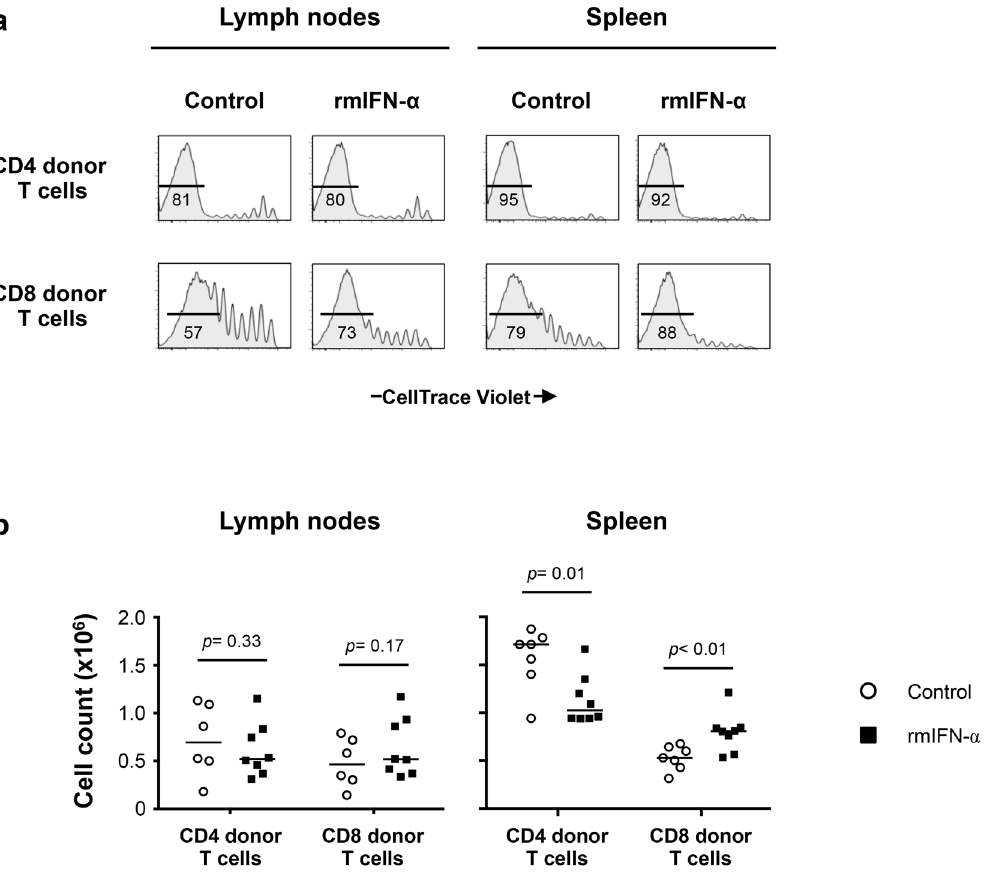
Figure 7. Continuous exposure to Type-I IFN under lymphopenic conditions leads to CD4 T cell depletion and CD8 T cell expansion. Lymphopenic RAG 2 / 2 mice reconstituted with CellTrace Violet-labeled LN cells from congenic B6 CD45.2 mice were treated with either rmIFN- a (10,000 U per mouse, daily; n=8) or PBS (n=7). The numbers of CD4 and CD8 donor T cells in LNs and spleen were determined on day 35 after transfer. ( a ) Percentages of highly dividing CD45.2 + CD3 + CD4 + and CD8 + donor lymphocytes in LNs and spleen are shown. ( b ) Absolute numbers of CD4 + and CD8 + donor T cells in the lymphoid organs were enumerated following the treatment with rmIFN- a (black symbols) and PBS (open symbols). A nonparametric Mann-Whitney test was performed for comparisons of CD4 and CD8 T cell counts between groups. Data are from two representative experiments out of four, including an average of 4 mice per group.